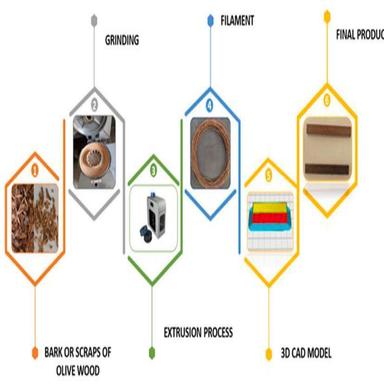
Scheme of the steps of the FFF printing process, starting from olive wood up to the printing of the 3D object using PLA/OW composite filament.